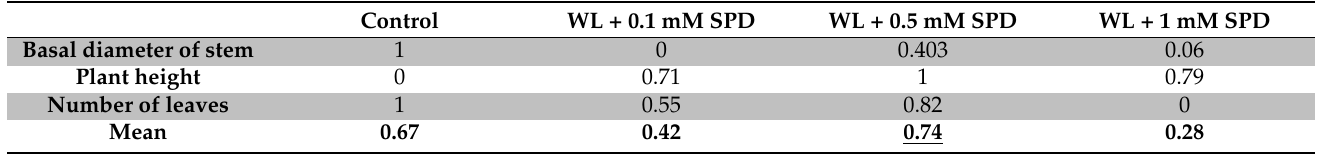
Table 1. Subordinate function analysis of exogenous SPD at different concentrations in C. oleifera seedlings under